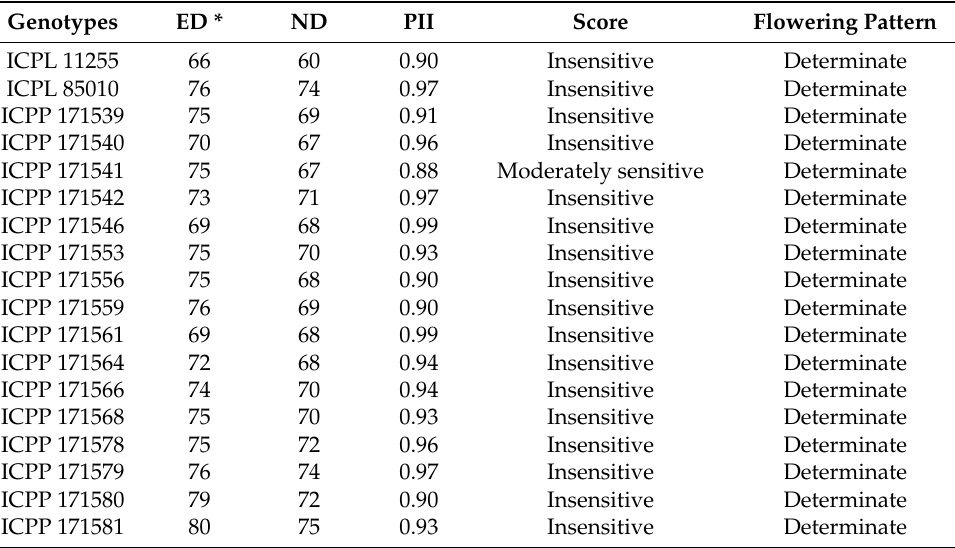
Table 3. Days to flowering under different photoperiods and photoperiod insensitivity indexes of extra-early maturing pigeonpea introgression lines at ICRISAT, Patancheru, India.